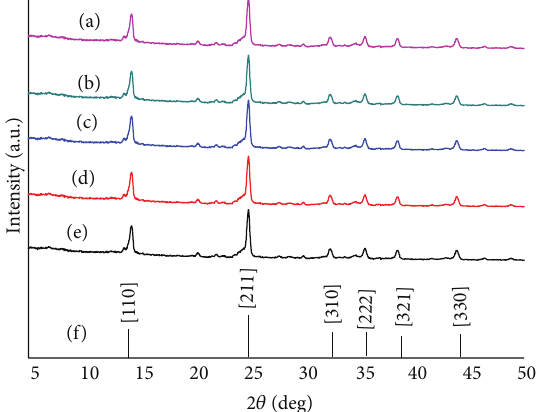
Figure 1: XRD patterns of synthesized samples using fumed silica as silica source, (a) sodalite without template, (b) organosilane, (c) TPA, (d) CTABr, and (e) TPA and CTABr 1: 1 as templates, as well as (f) reference for sodalite (Zeolite 16:323-802, 1996).